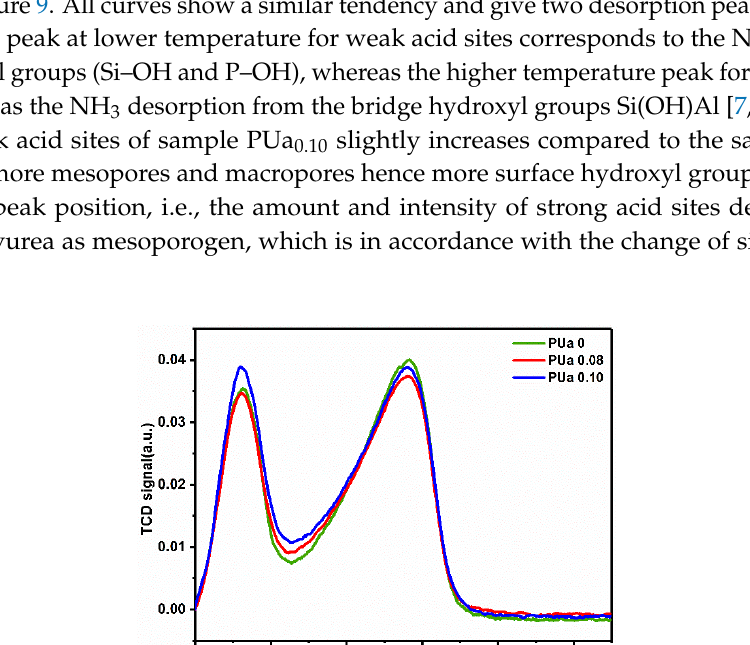
(c) Figure 10. Time-dependent XRD patterns of ( a ) PUa 0 , ( b ) PUa 0.08 , ( c ) relative crystallinity evolution with crystallization time. 2.3. Catalytic Performance for MTO Reaction